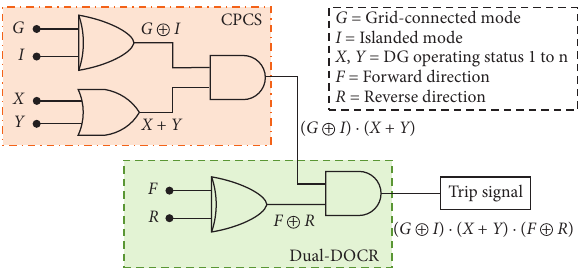
Figure 9: Symbolic decision-making logic for the operation of dual-DOCR.